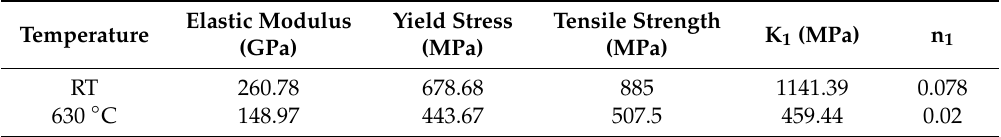
Figure 6. The true stress–strain curves of 9%Cr turbine steel at RT and 630 ◦ C. ( a ) monotonic stress-strain curves; ( b ) strain hardening exponent fitted by Equation (1). Table 2. Tensile properties of 9%Cr turbine steel at RT and 630 ◦